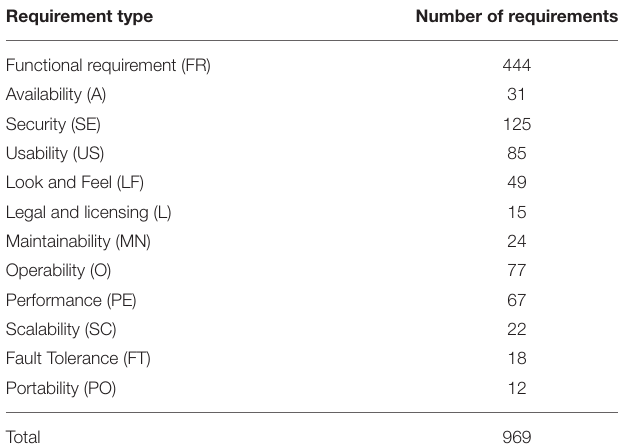
TABLE 2 | Number of requirements per class.